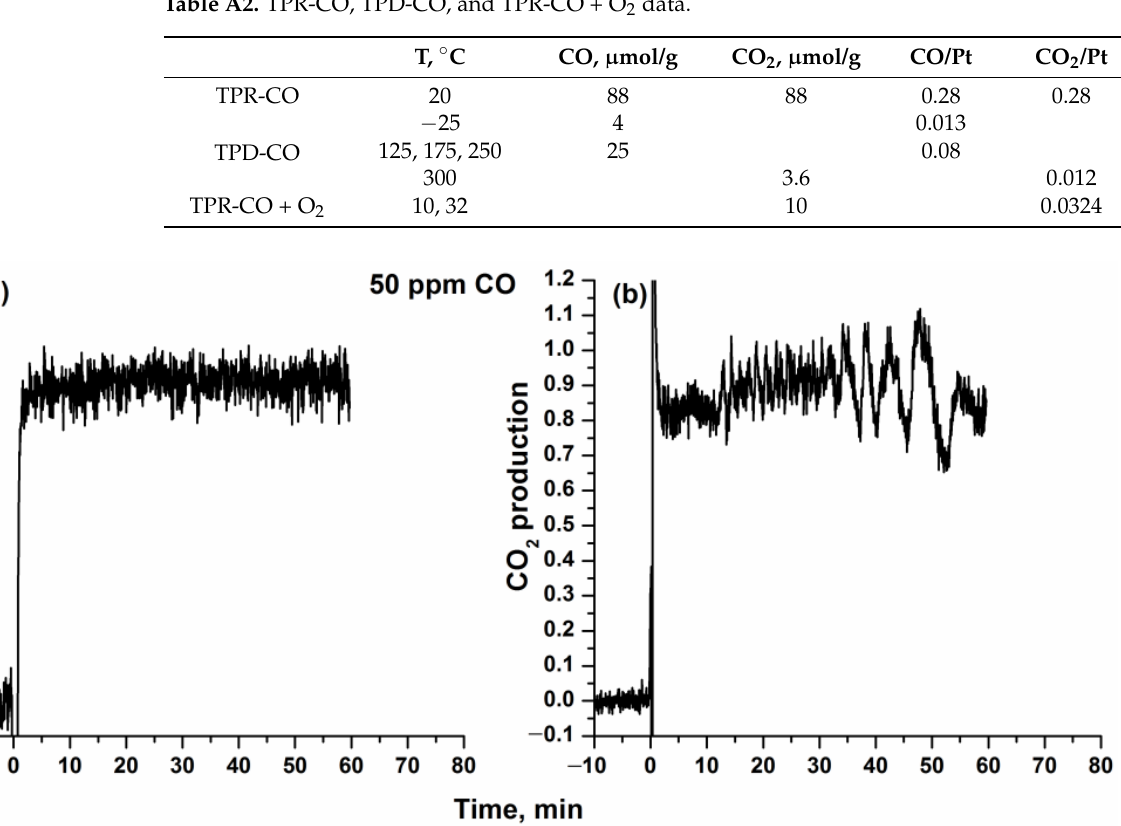
Table A1. Catalytic characteristics of the Pt foil and the Pt-C catalyst.